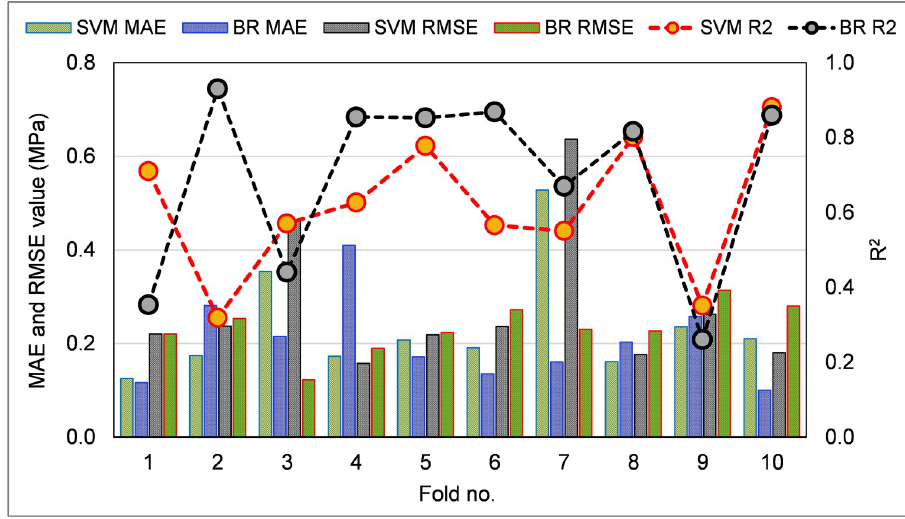
Fig 11. Outcomes of k-fold